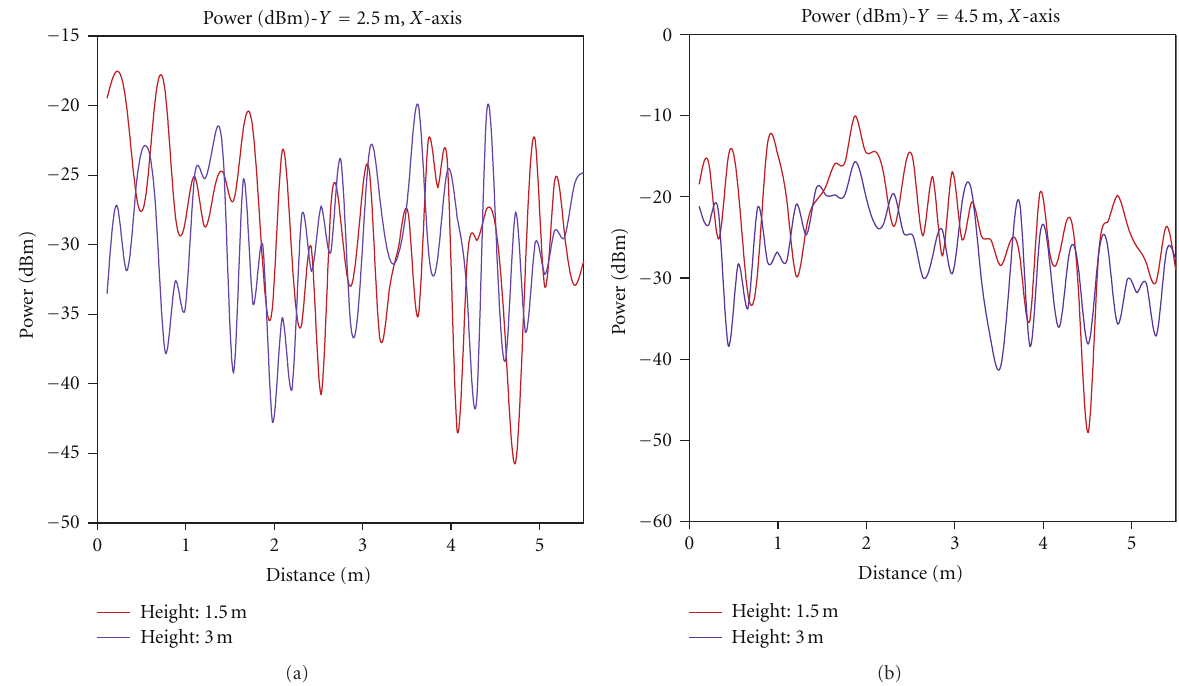
Figure 13: Distribution of power for di ff erent points of Y along the X -axis and for di ff erent heights.